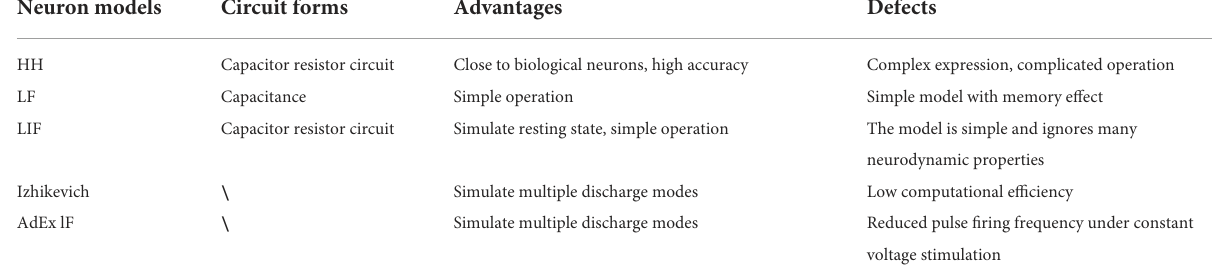
TABLE 1 Comparison of neuronal